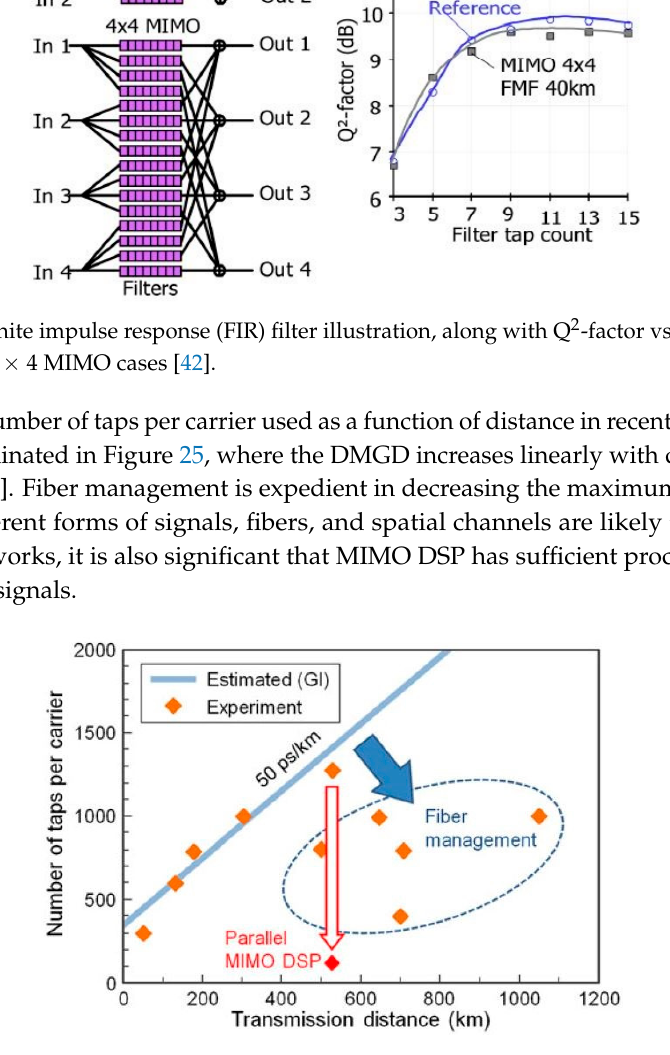
Figure 25. The number of taps per carrier for MIMO DSP vs. distance in recent few-mode fiber (FMF) transmission experiments [19].